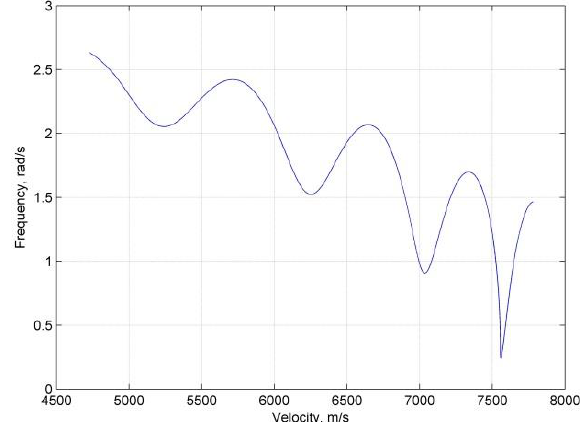
Figure 1. Typical frequency variation in skipping re-entry.